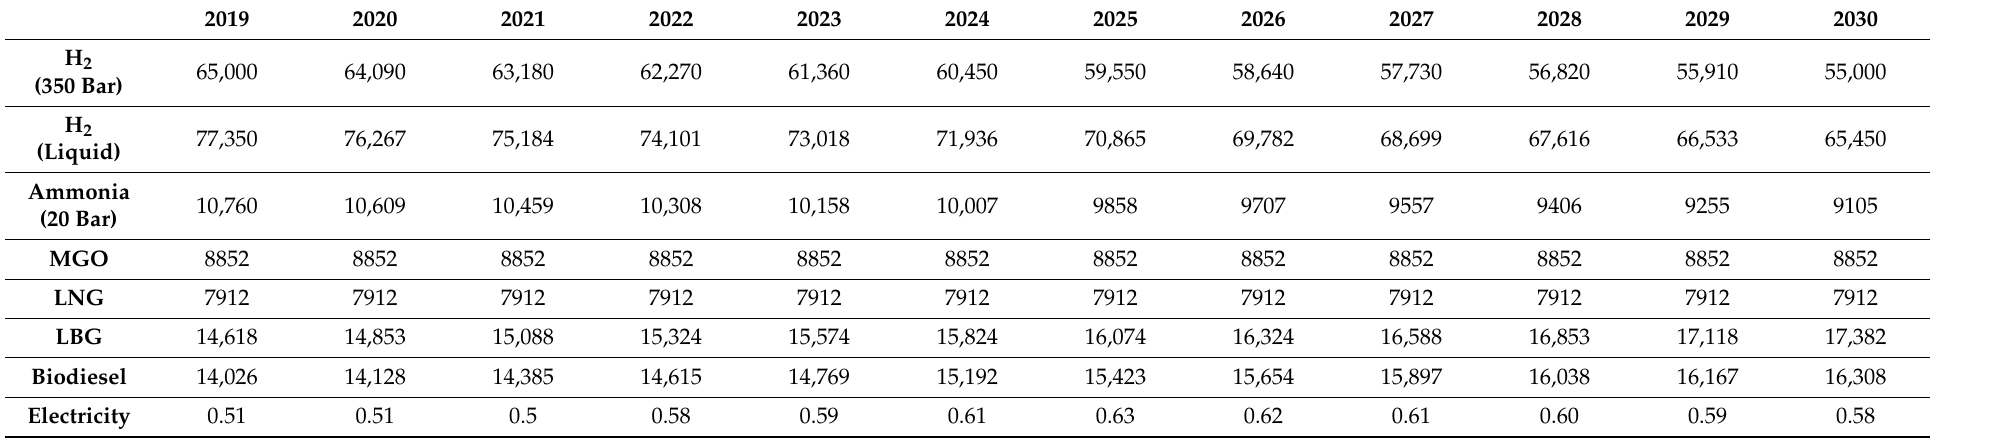
Table 4. Marine fuel price predictions from